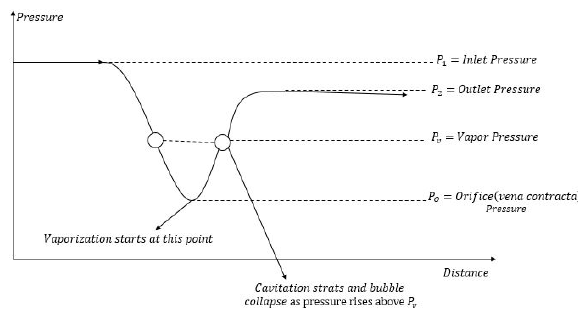
Figure 1: Pressure distribution of the fluid across the channel